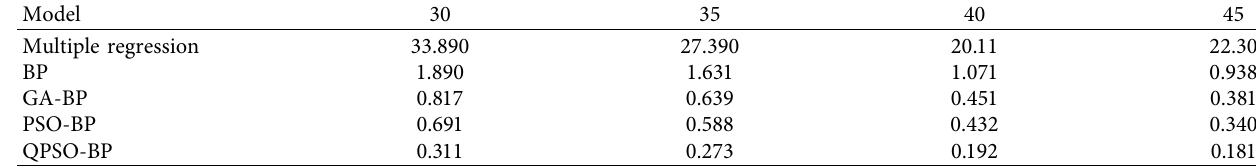
Table 6: Stability of calculation results under different sample numbers.